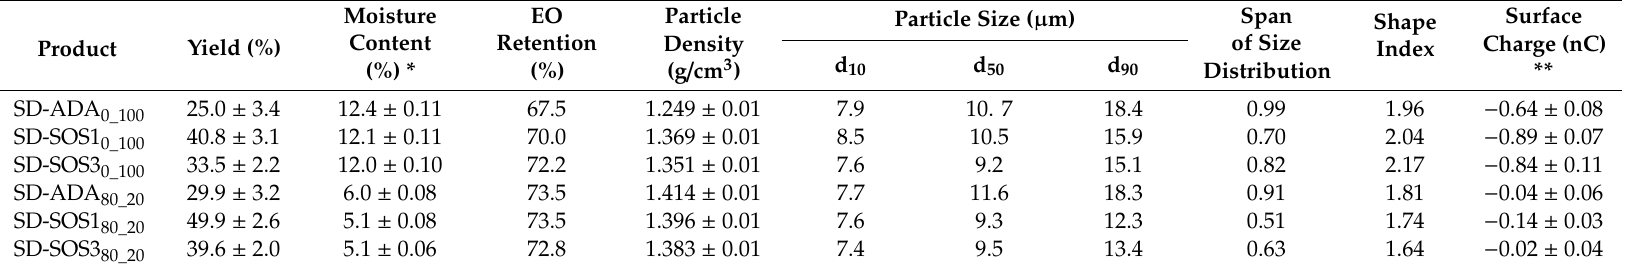
Table 3. Product yield, EO retention, moisture content, and physical properties of the spray-dried